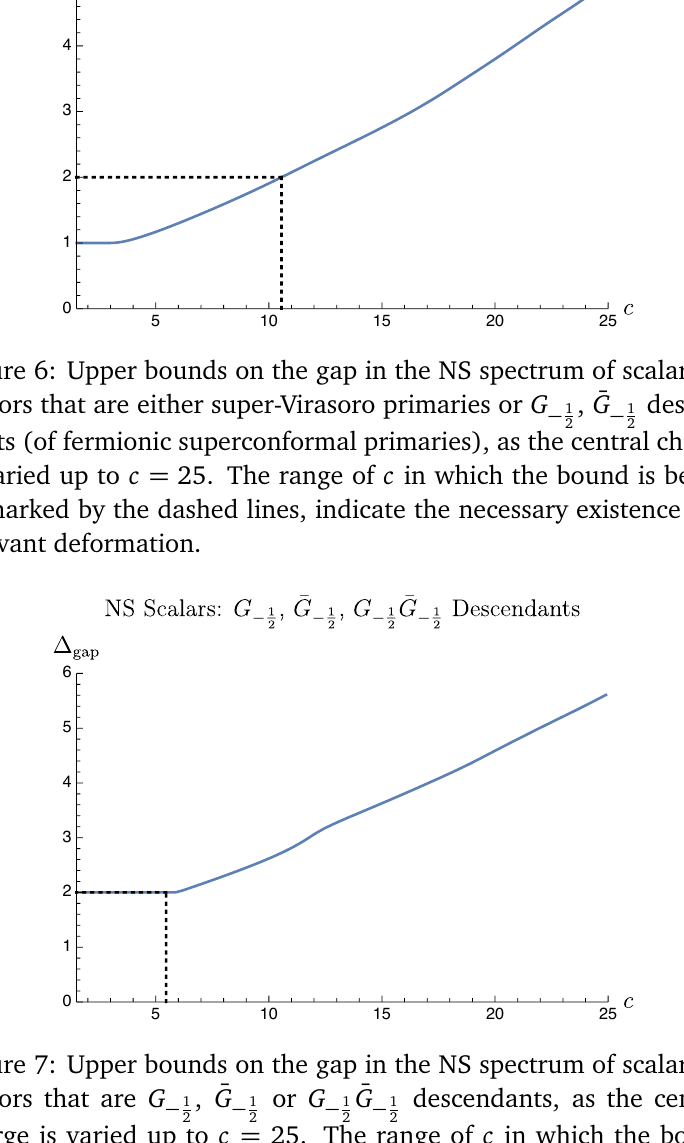
¯ G , ¯ G − 1 or G − 1 descendants, as the central − 1 2 2 2 2